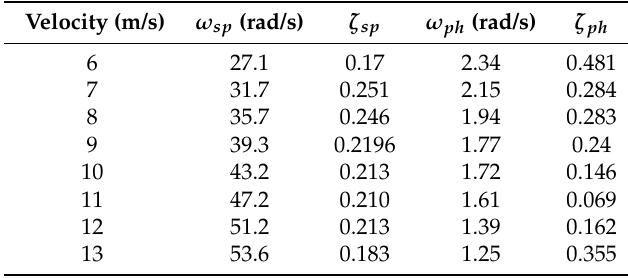
Table 10. Variation of natural frequencies and damping ratio of longitudinal modes of MAV. Velocity (m/s) ω sp (rad/s) ζ sp ω ph